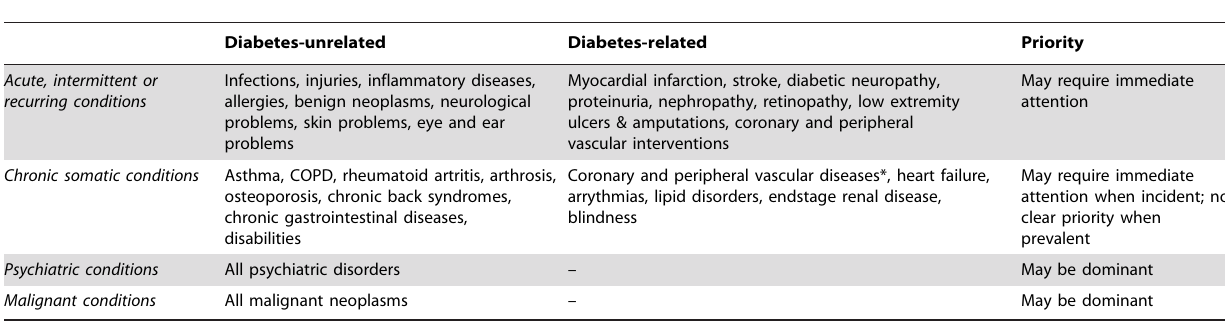
Table 1. Classification scheme for comorbidity typology.